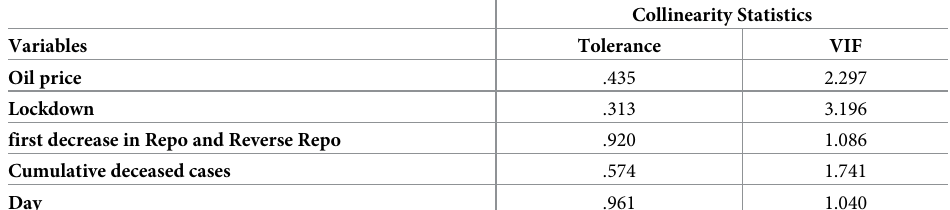
Table 4. Variable inflation factor analysis with TASI as dependent variable after dropping highest VIF.